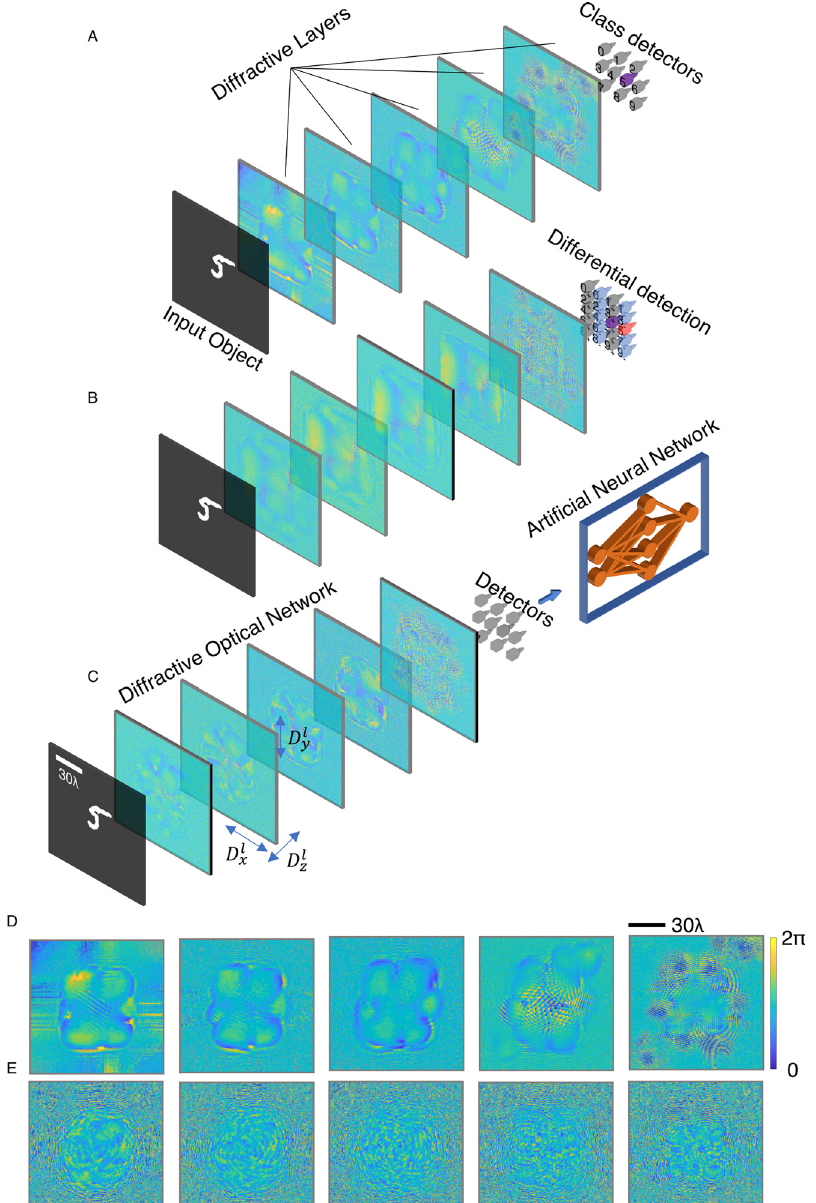
Figure 1: Different types of D 2 NN-based im- age classi fi cation systems. (A) Standard D 2 NN framework trained for all-optical classi fi cation of handwritten digits. Each data class. (B) Differential D 2 NN trained